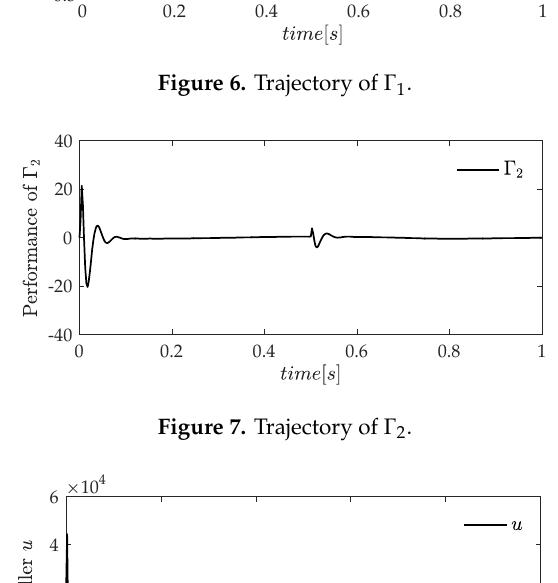
Figure 6. Trajectory of Γ 1 .